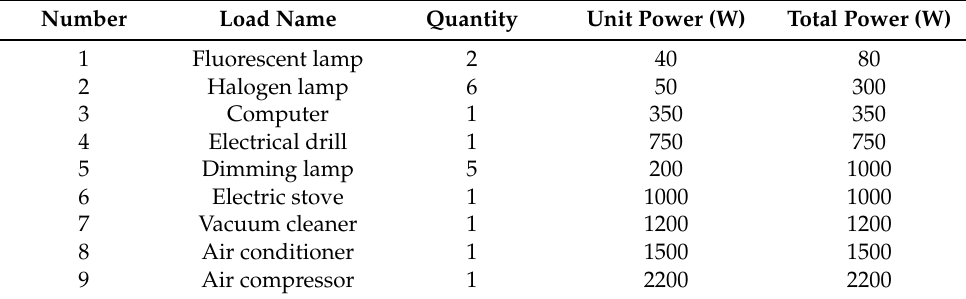
Table 1. Typical experimental loads.